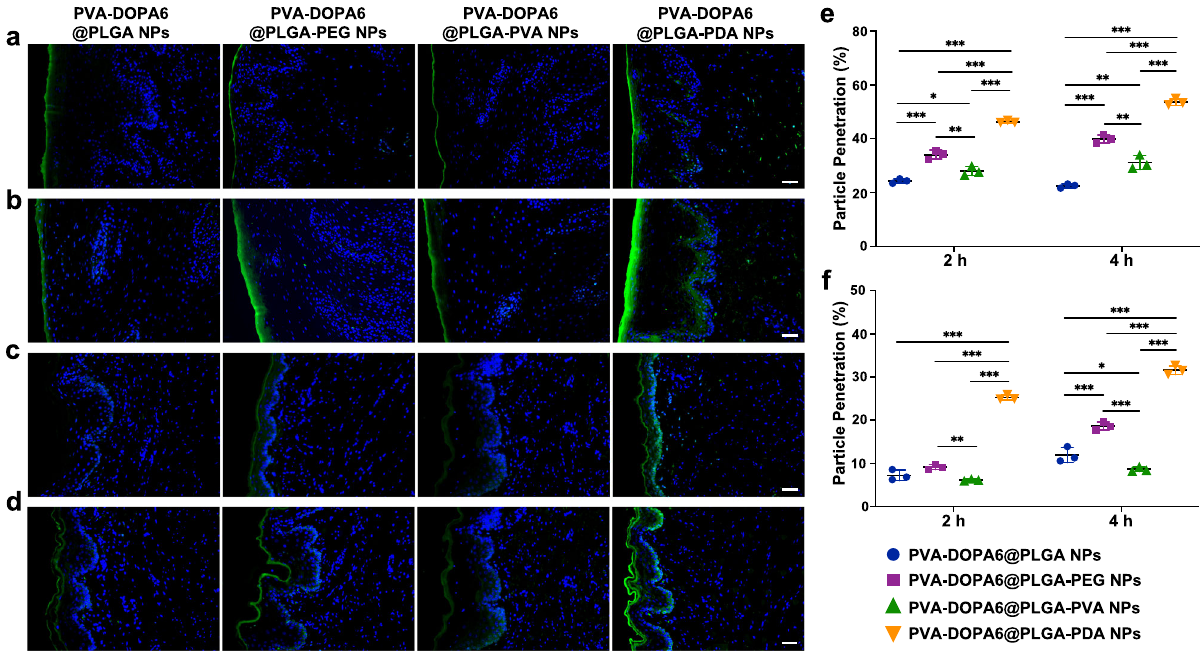
Fig. 6 Ex vivo and in vivo permeation studies. a, b Ex vivo distribution of different NPs in porcine buccal tissue incubated for 2 h and 4 h, respectively. Scale bars: 100 μ m. PVA: poly(vinyl alcohol), DOPA: 3,4-dihydroxy-D-phenylalanine, PLGA: poly(lactic-co-glycolic acid), PEG: poly(ethylene glycol), PVA: poly(vinyl alcohol), PDA: polydopamine. c, d In vivo distribution of different NPs in rat buccal tissue incubated for 2 h and 4 h, respectively. Scale bars: 100 μ m. e Quanti fi cation of the fl uorescence intensity of different NPs obtained from fl uorescence images of porcine buccal tissue. * P = 0.031; ** P < 0.01; *** P < 0.001. f Quanti fi cation of the fl uorescence intensity of different NPs obtained from fl uorescence images of rat buccal tissue. * P = 0.033; ** P = 0.005; *** P < 0.001. All data are Mean± S.D. n = 3 animals per group. Statistics was calculated by one-way ANOVA followed by Tukey ’ s post-test. Exact P values are given in the Source Data fi le. Source data are provided as a Source data fi